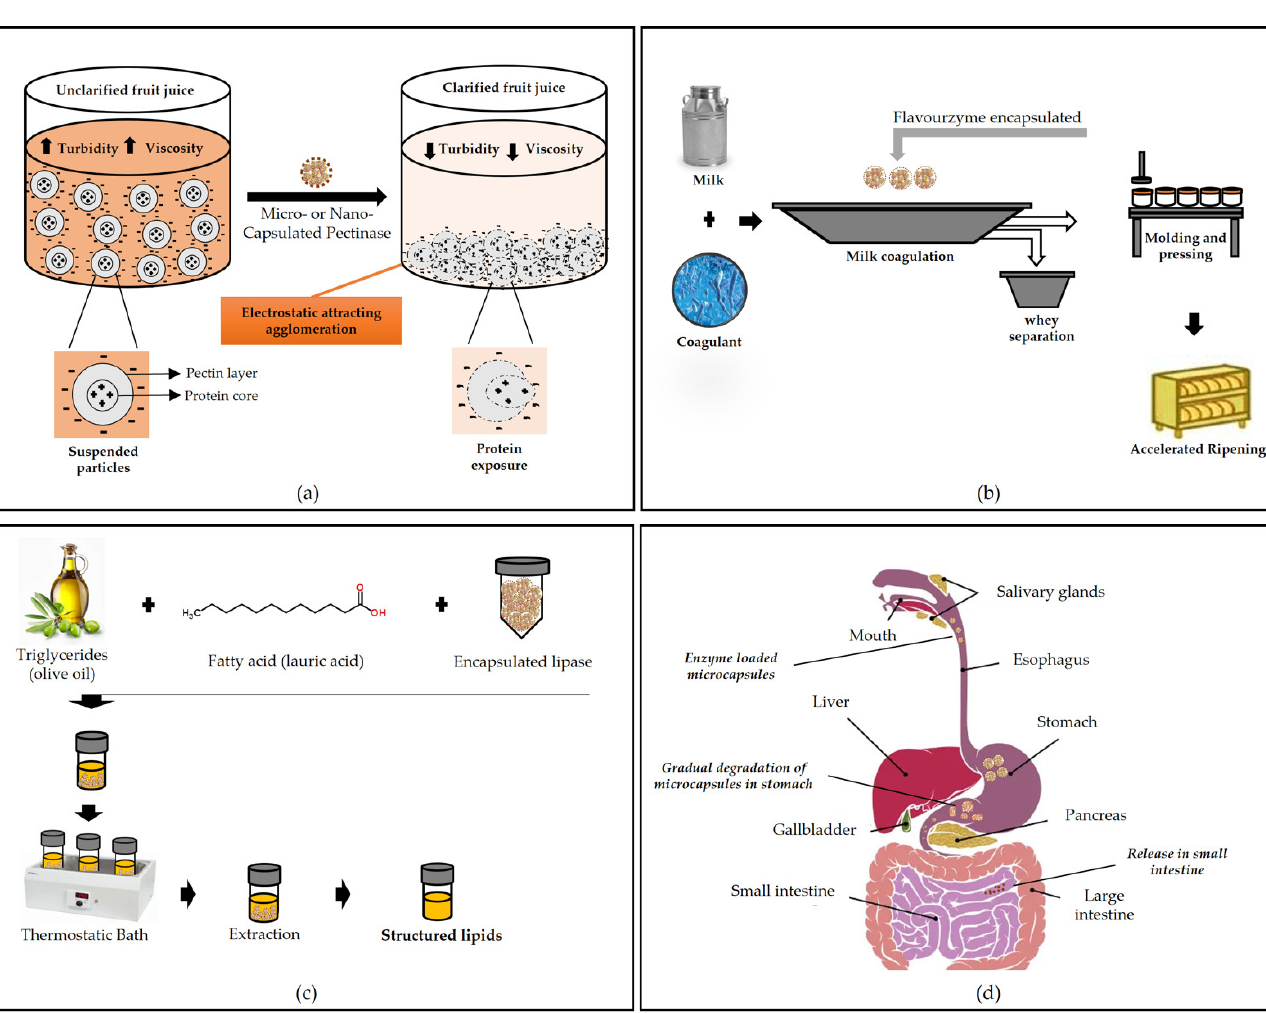
Figure 5. Application of microcapsules containing enzymes: ( a ) juice clarification, ( b ) cheese maturation, ( c ) biocatalysis of structured lipids, and ( d ) oral drug delivery.